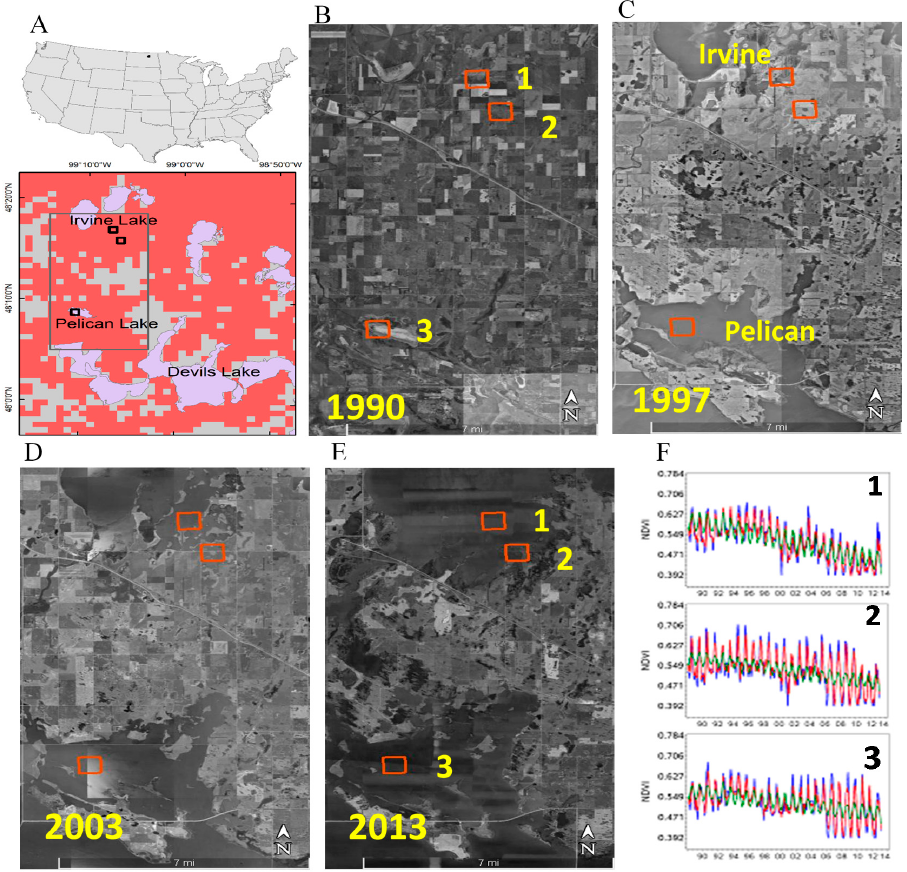
Figure 5. Progression of agriculture and flooding between 1990 and 2013 in Devils Lake area, North Dakota: ( A ) inset map shows the location of the area within the Devils Lake and the selected three numbered 1 km × 1 km pixels; ( B – E ) Google Earth TM images showing the: pre flooding ( A ); and post flooding ( C – E ); and ( F ) numbered pixels 1–3 in ( A – E ) are used in F1–F3, showing the behavior of NDVI with years. NDVI trend with time ( β 6 < − 0.077) is significant ( p < 0.0001) (lines are described in Figure S2). The coordinates for pixels 1–3 are 48°17 ′ 05 ″ N, 99°07 ′ 16 ″ W; 48°16 ′ 01 ″ N, 99°06 ′ 23 ″ W; and 48°10 ′ 50 ″ N, 99°10 ′ 53 ″ W; respectively.